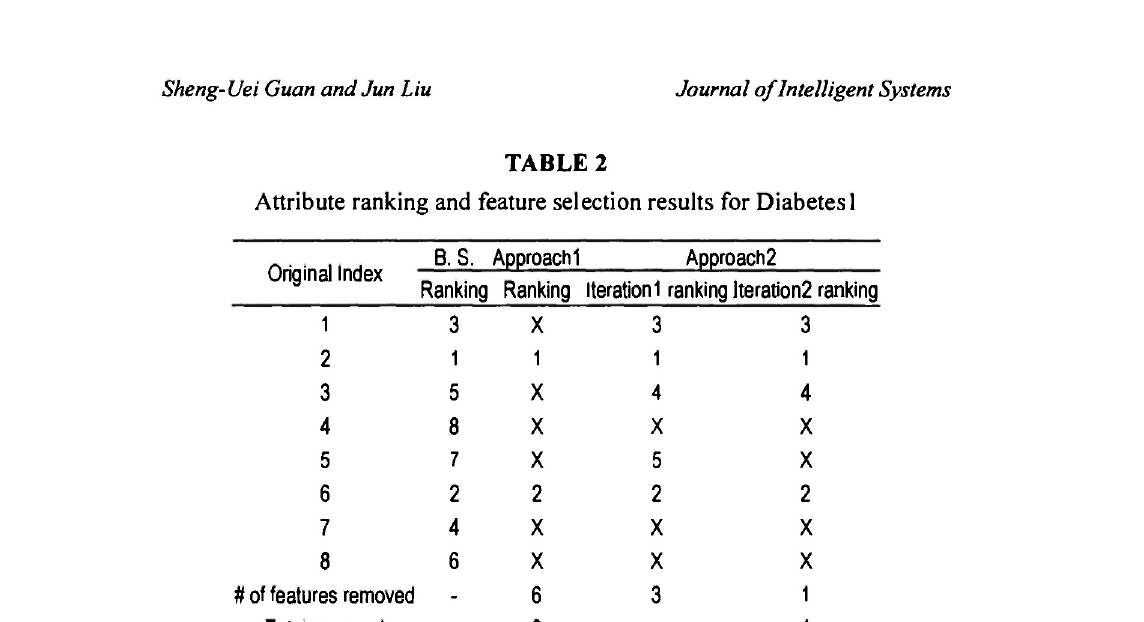
Comparison of the network performance obtained by two feature selection methods for Diabetes